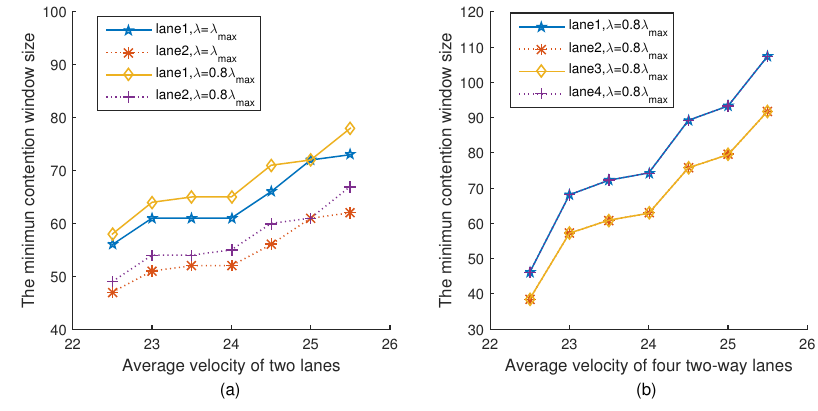
Figure 9. Minimum contention window versus